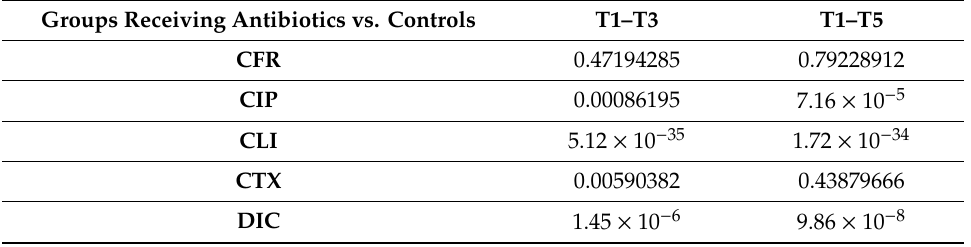
Figure 2. Box plot of the similarity of gut microbiota at day 3 and 5 compared to the initial microbiota. The y-axis represents cosine similarity values, for pairs of IS-profiles of the microbiota at different dates (higher value means higher similarity to pretreatment microbiota). Shown here is the normal variation and the variation induced by antibiotic treatment. Boxes represent the cosine similarity values for all five mice in each group. Table 1. P-values for the beta similarity between day 1 (T1) and day 3 (T3), as well as day 1 and day 5